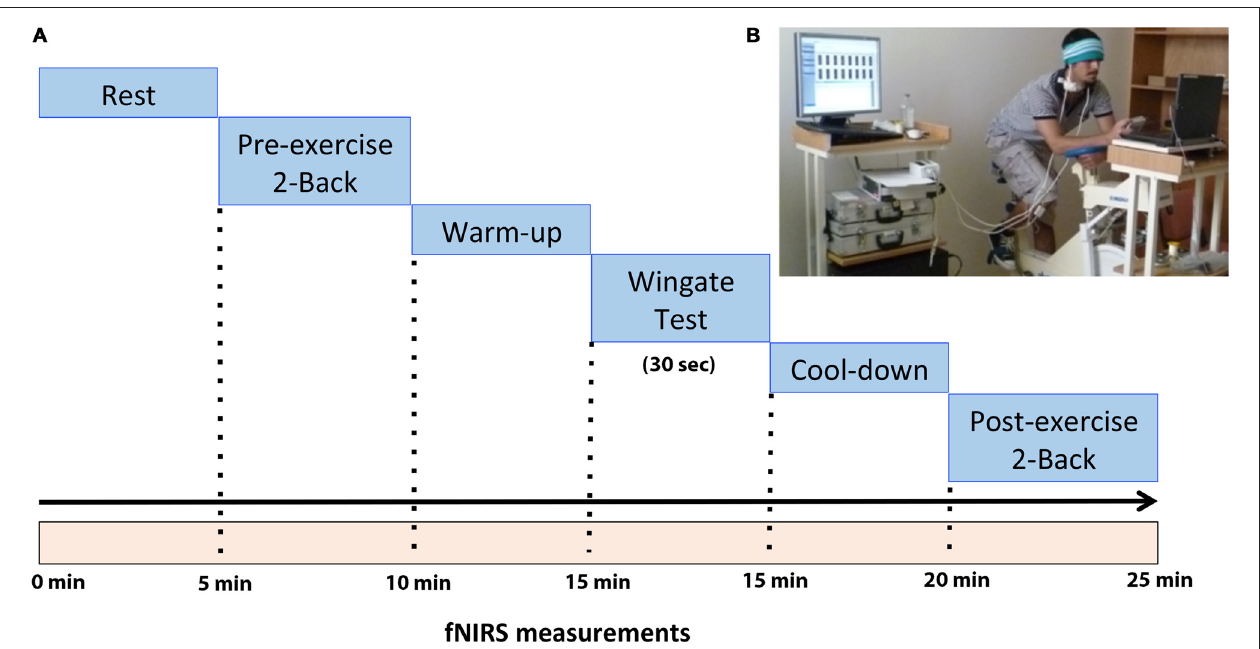
FIGURE 1 | (A) The demonstration of experimental design for the current study. (B) Participant seated at cycle ergometer during whole